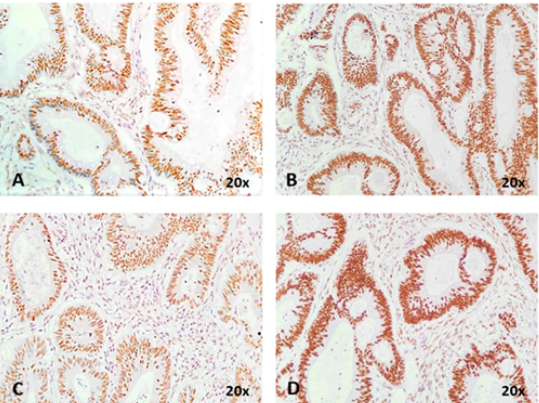
Figure 6. The microsatellite stable status is immunohistochemically proved by nuclear expression of MLH1 ( A ), MSH2 ( B ), PMS2 ( C ) and MSH6 ( D